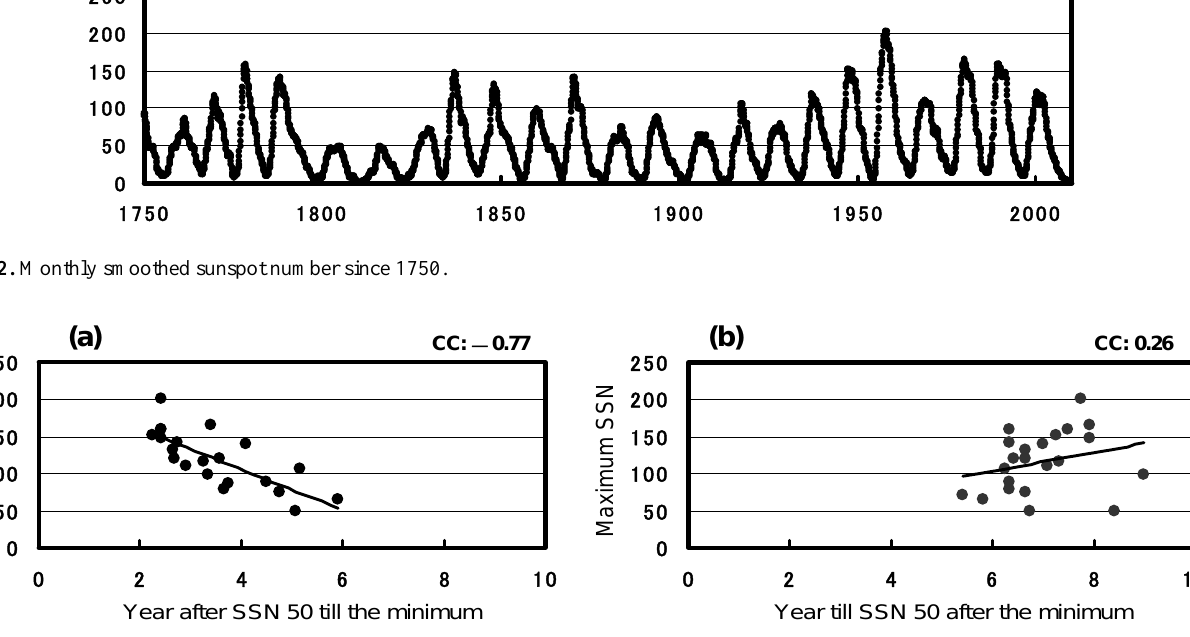
Fig. 3. (a) Peak sunspot number in the succeeding cycle versus time required for the sunspot number to decrease from a value of 50 to its minimum value during the decaying phase. (b) Peak sunspot number in the succeeding cycle versus time required for the sunspot number to increase from its minimum, pass through its maximum, and decrease to a value of